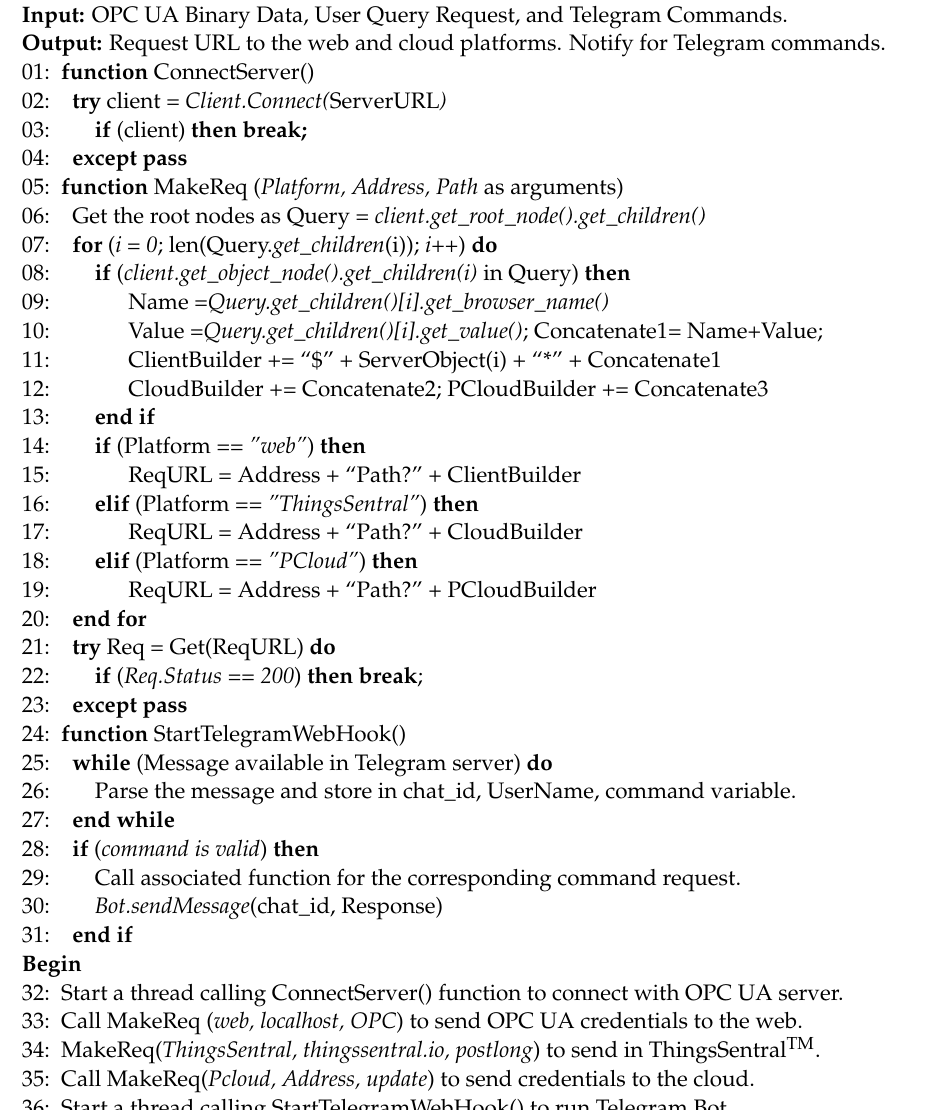
Algorithm 2. REST-based OPC UA Middleware Module Development